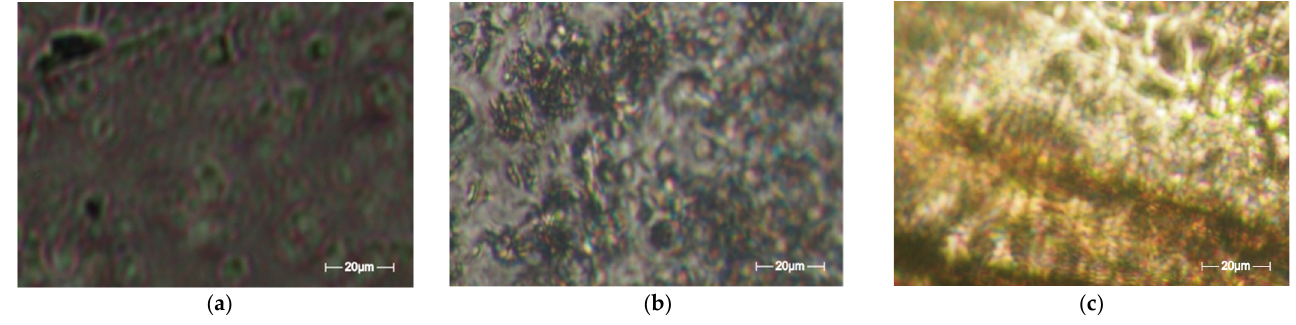
Figure 5. Typical POM pictures of the compounds/formulations: ( a ) POM ‐ P 1 ; ( b ) POM ‐ P 2 ; ( c ) POM ‐ P 4.